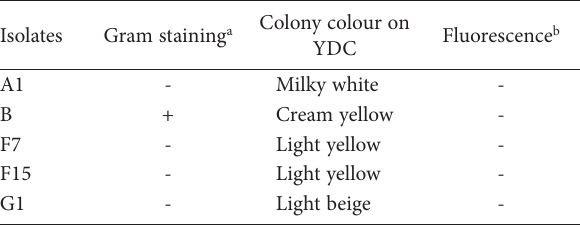
Table 1. Morpho-physiological characteristics of wheat bacterial endophyte isolates.